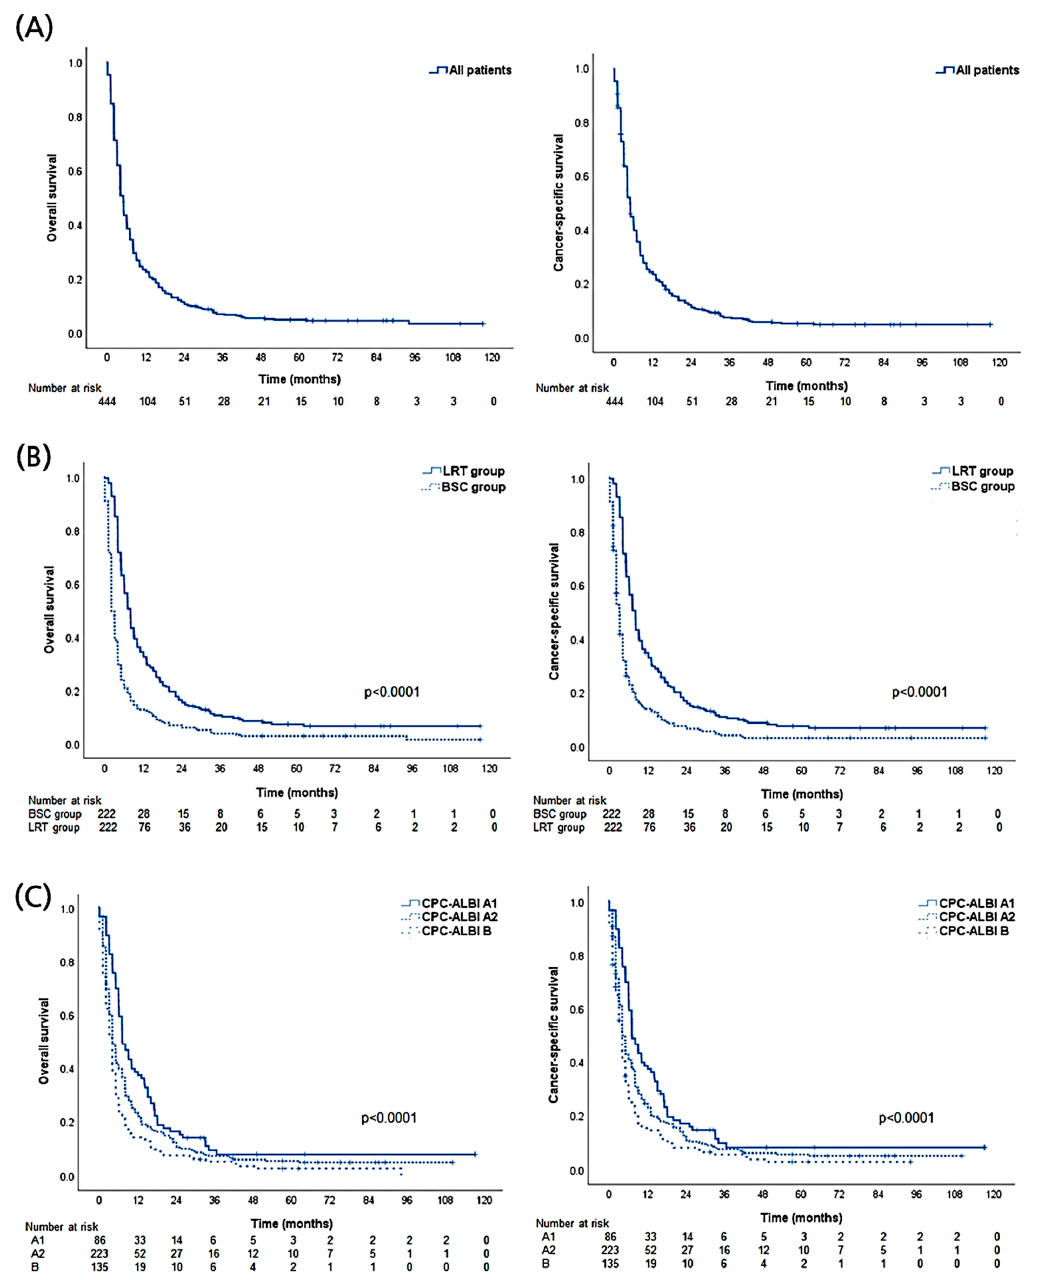
Figure 2. Descriptive graphs of overall and cause-specific survival. ( A ) All propensity-score matched patients. ( B ) Local treatment including radiotherapy (LRT) versus best supportive care (BSC) groups. ( C ) Comparison among subgroups according to Child-Pugh class (CPC) and Albumin-Bilirubin index (ALBI).